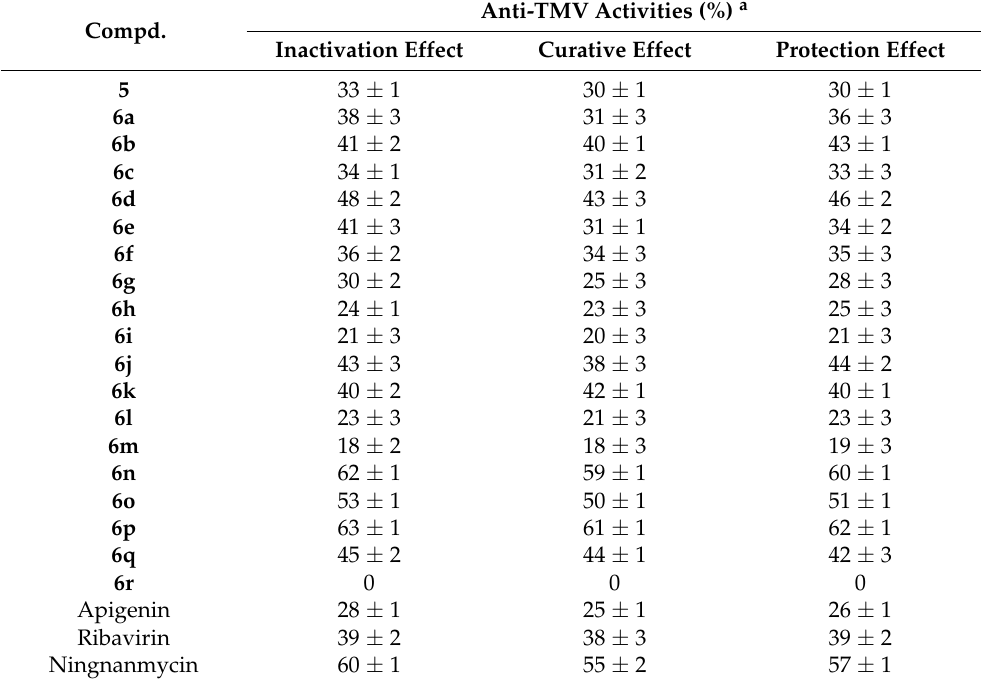
Table 1. In vivo antiviral activity of compounds 5 and 6a – 6r against TMV. Compd.